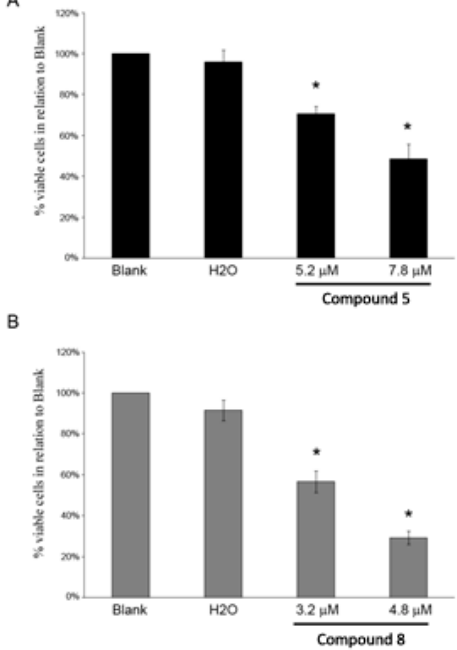
Figure 1. NCI-H460 viable cell number 48 h following treatment with compounds 5 ( A ) and 8 ( B ) analyzed with trypan blue exclusion assay. Cells were treated with the GI 50 (5.2 μ M) and 1.5× GI 50